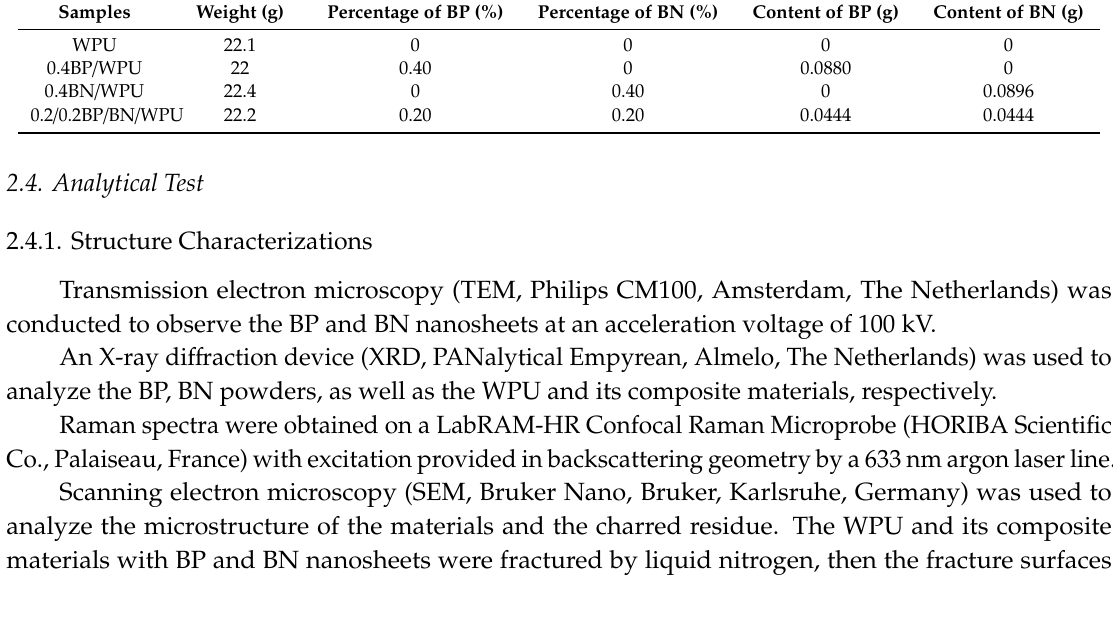
Table 1. The additive amount of the BP and BN nanosheets in the samples.